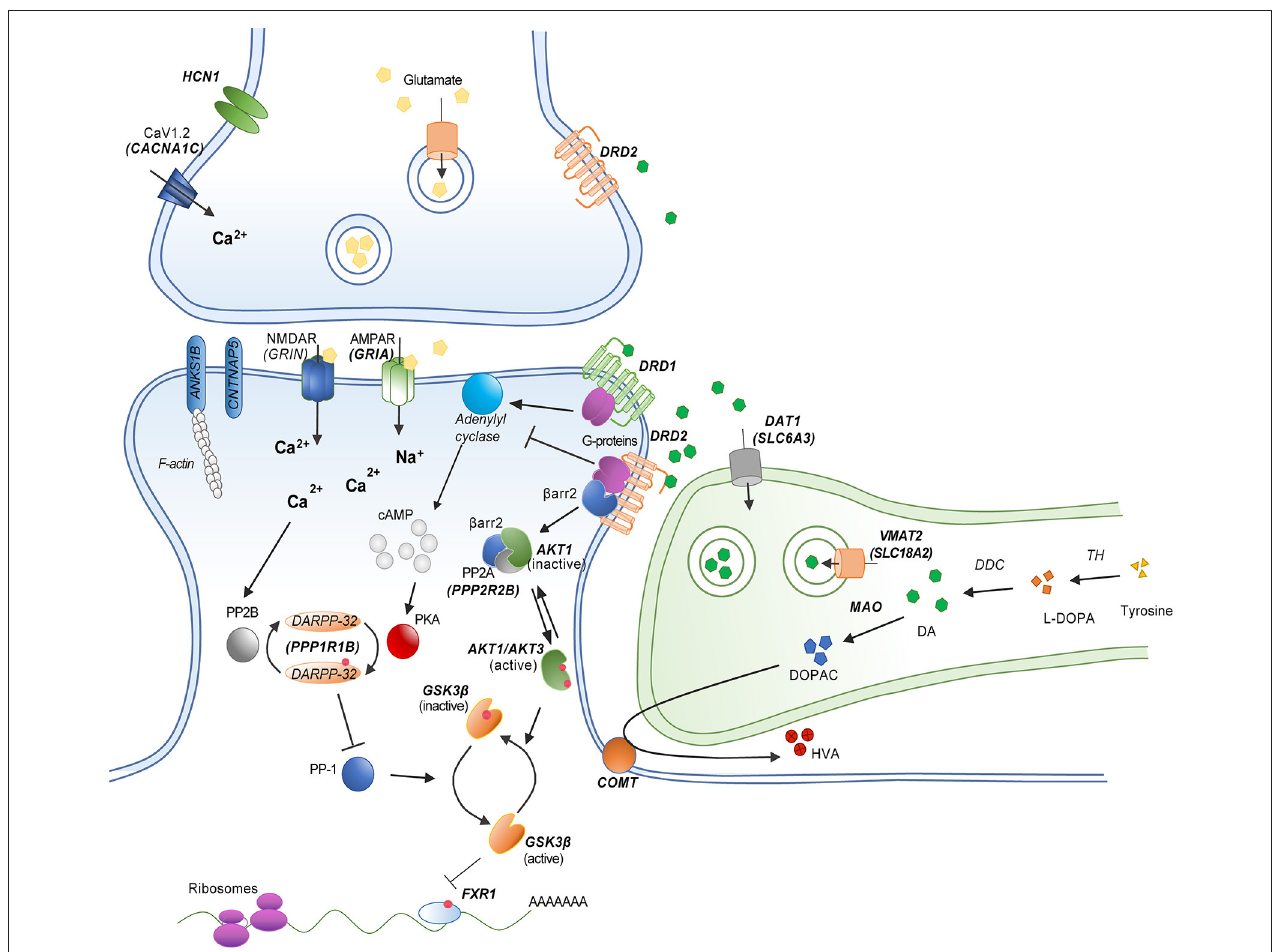
FIGURE 1 | Schematic model of a striatal dopamine/glutamate synapse showing the functional relationship between different dopamine related gene products. Genes implicated in candidate gene studies and/or GWAS are indicated in bold. Red dots represent phosphorylation